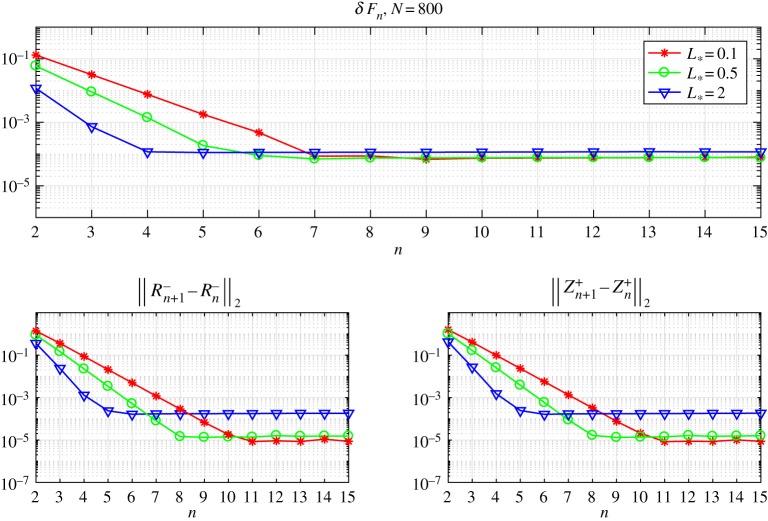
The discrepancy of the equation and the norms of errors versus the number of iterations for a fixed number of integration points N = 800. (Online version in colour.)